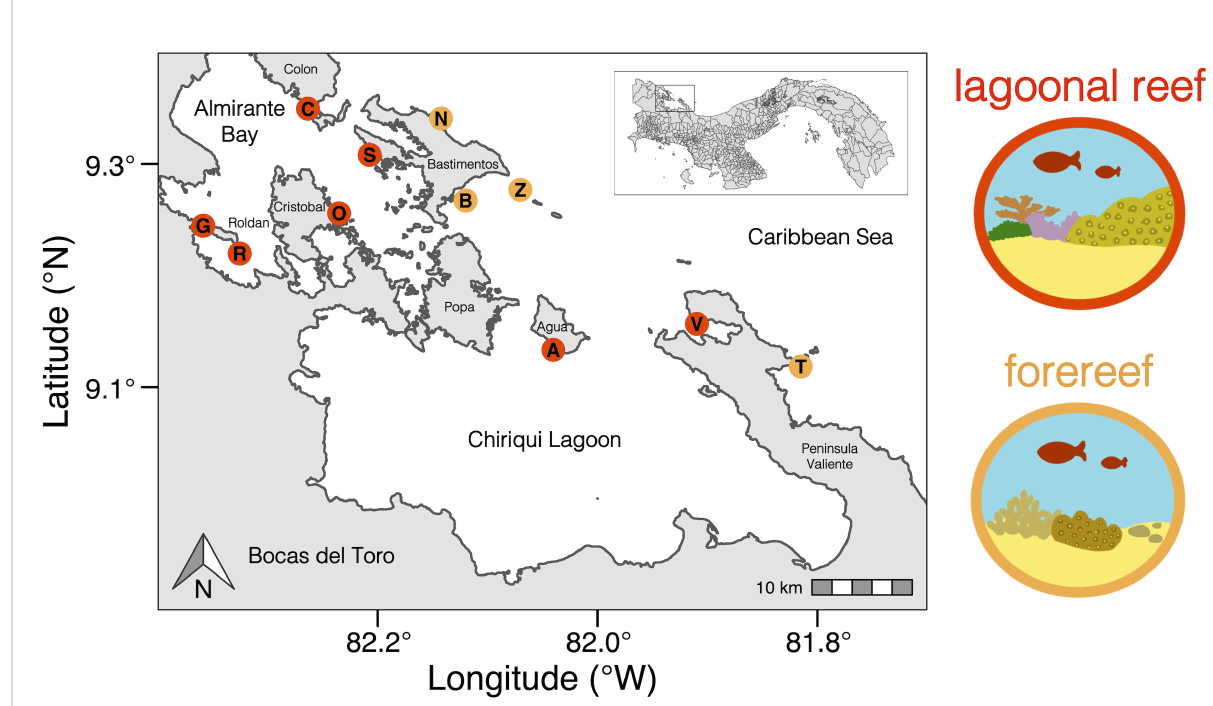
FIGURE 1 Map showing the location of each reef community in Bocas del Toro, Panama. Colouring corresponds to reef type: lagoonal reef or forereef. Letters represent reef community locations: Isla Colon ( C ), Cayo Roldan ( R ), Isla Cristobal Sureste ( O ), Isla Solarte ( S ), Isla Bastimento ( B ), Cayo Agua ( A ), Isla Bastimento Norte ( N ), Zapatilla Oeste ( Z ), Peninsula Valiente ( V ), Tobobe ( T ), Almirante Pta. Gallinazo ( G